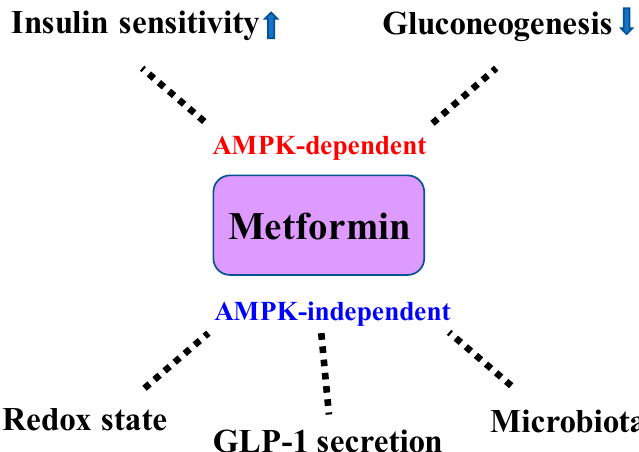
Figure 1. Glucose-lowering mechanisms of metformin. Metformin inhibits hepatic gluconeogenesis and improves insulin sensitivity via AMPK activation. Importantly, metformin has been shown to inhibit hepatic gluconeogenesis in the absence of AMPK. Changes in redox state and gut microbiota as well as GLP-1 secretion by metformin have been implicated in AMPK-independent